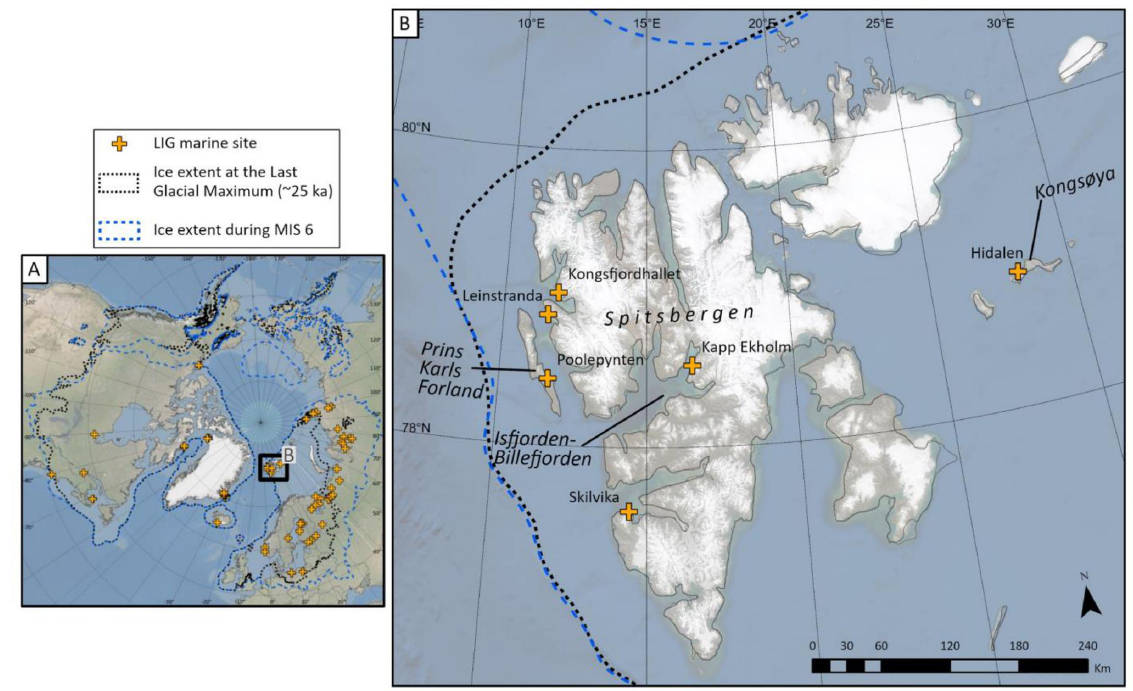
Figure 8. The locations of LIG marine sites in Svalbard, Norway. Panel (a) situates the sites in the Northern Hemisphere, whereas panel (b) provides a regional map. Sites plotted on this map are detailed in Sect. 6.34–6.39. Extent of MIS 6 and Last Glacial Maximum ice sheets after Batchelor et al. (2019). Scale calculated at the centre of the mapped area. Base layer: ArcGIS World